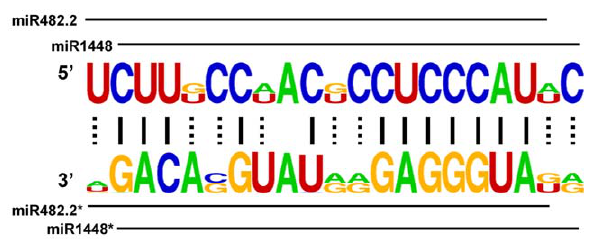
Figure 2. The nucleotide sequences of miR482 and miR1448 in Populus in the miRNA:miRNA* duplex.